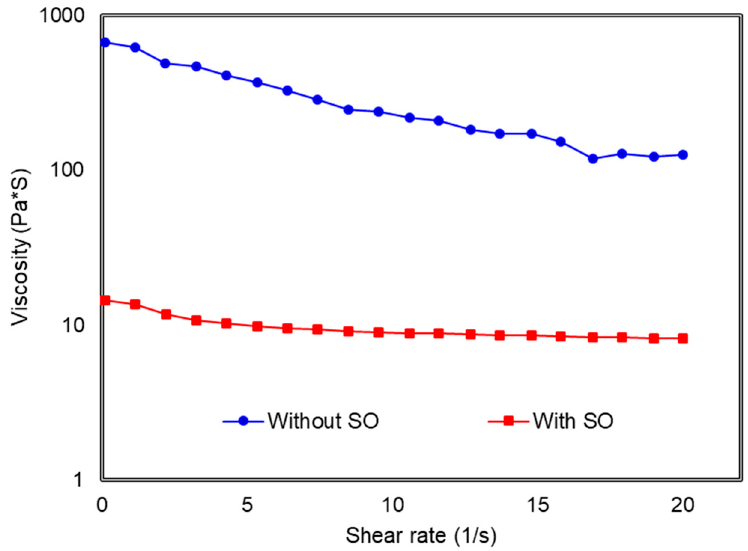
Figure 12. The viscosity of the uncured MRE samples with and without SO under the different shear rates.